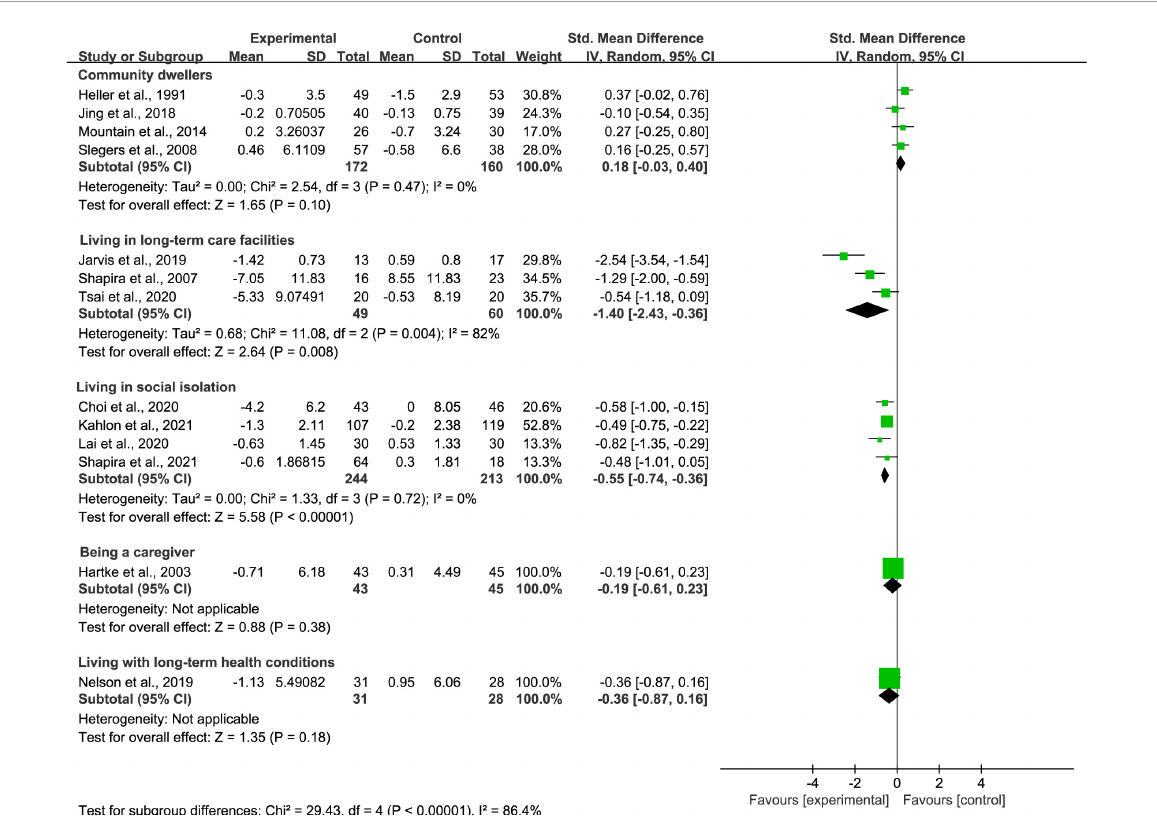
( p = 0.0004) suggested the result of the meta-analysis would be affected by publication